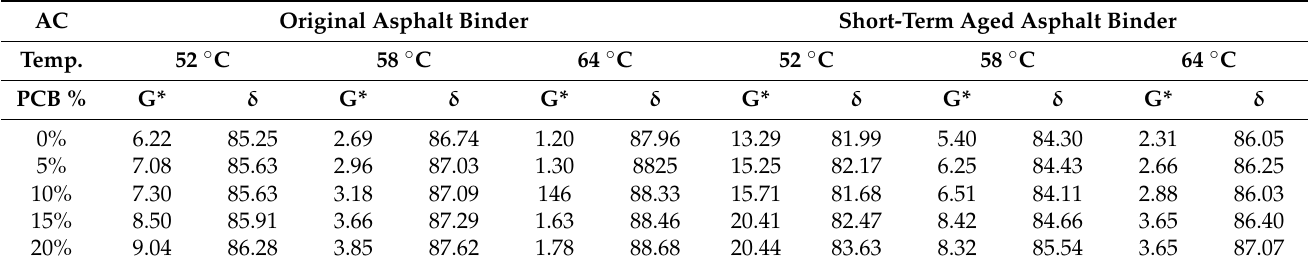
Table 6. Measured shear modulus and phase angle for short-term aged asphalt binder (AP-5).